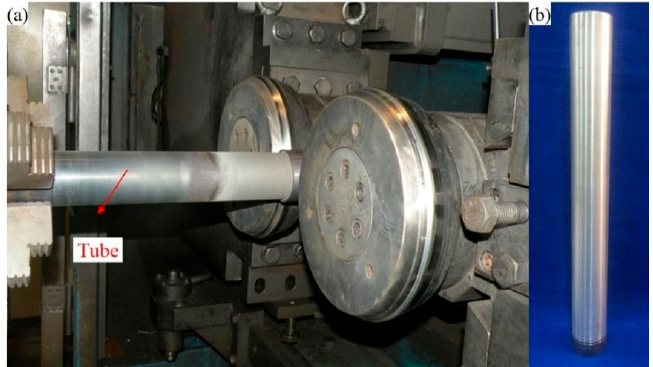
Figure 1. ( a ) Double-wheel spinning installation and ( b ) as-spun tube.